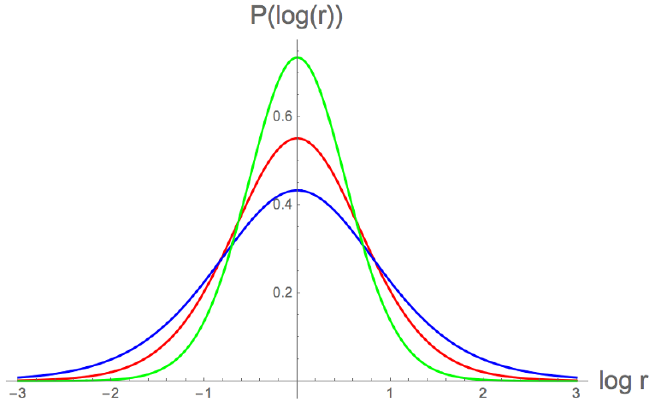
Figure 2 . The theoretical Wigner surmises for three di(cid:11)erent standard ensembles. The lower (blue), middle (red) and higher (green) curves are corresponding to GOE, GUE and GSE universal class